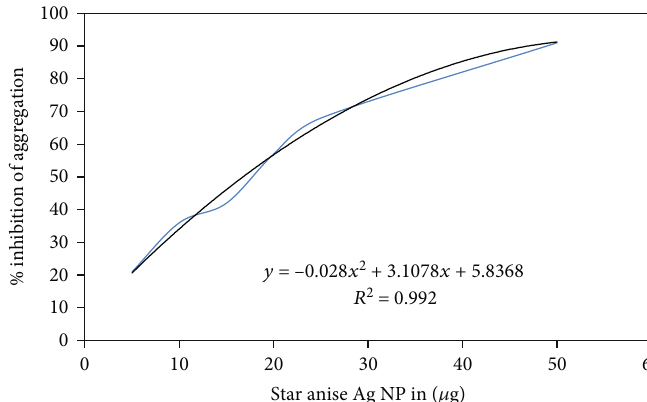
Figure 7: Inhibition of aggregation by SA-Ag-NP.